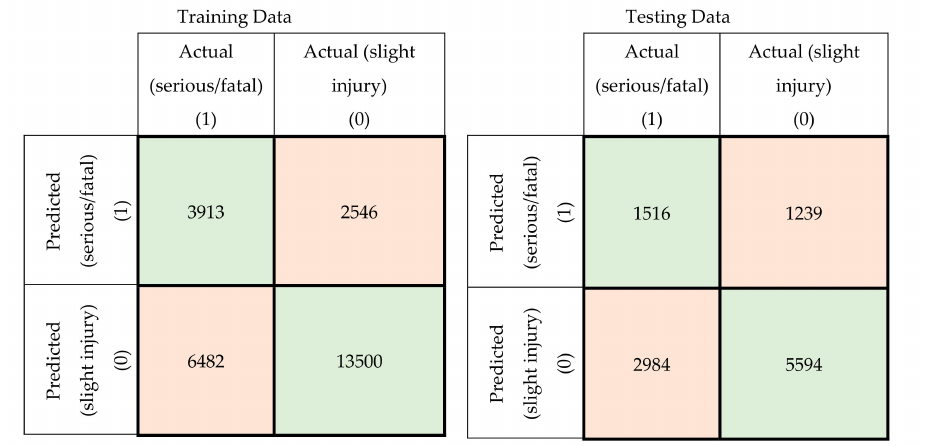
Figure 5. Confusion matrices for the MLP-NN model using original crash attributes (training and testing data).